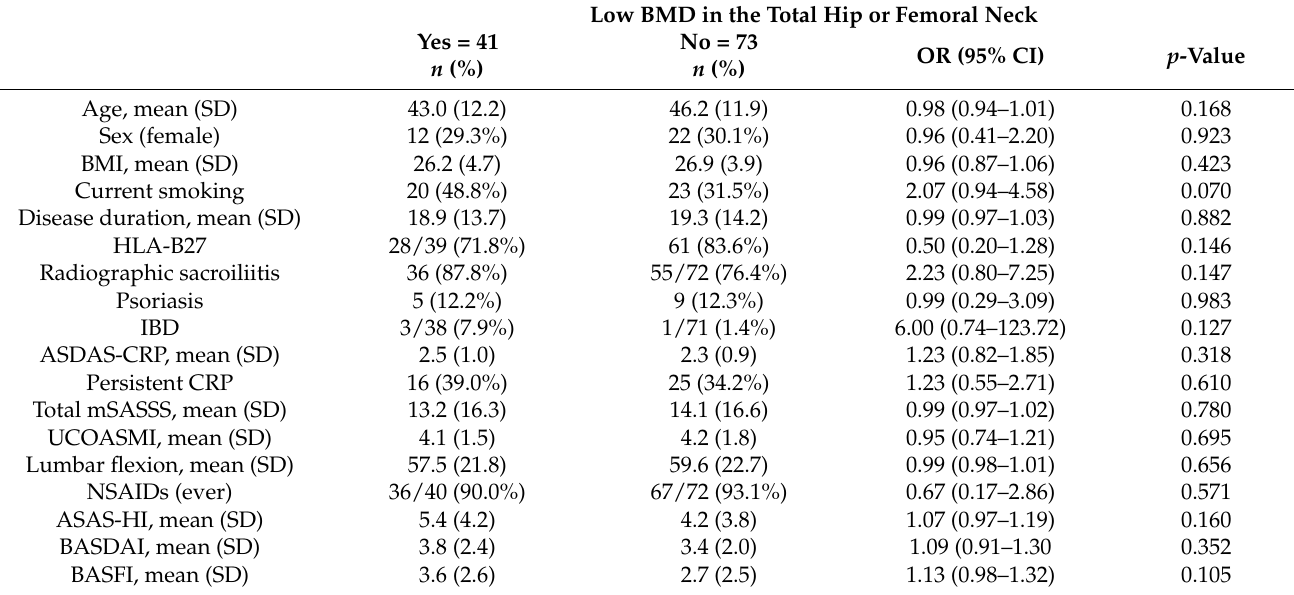
Table 2. Univariate logistic regression to evaluate the factors associated with low BMD in the total hip or femoral neck. Low BMD in the Total Hip or Femoral Neck